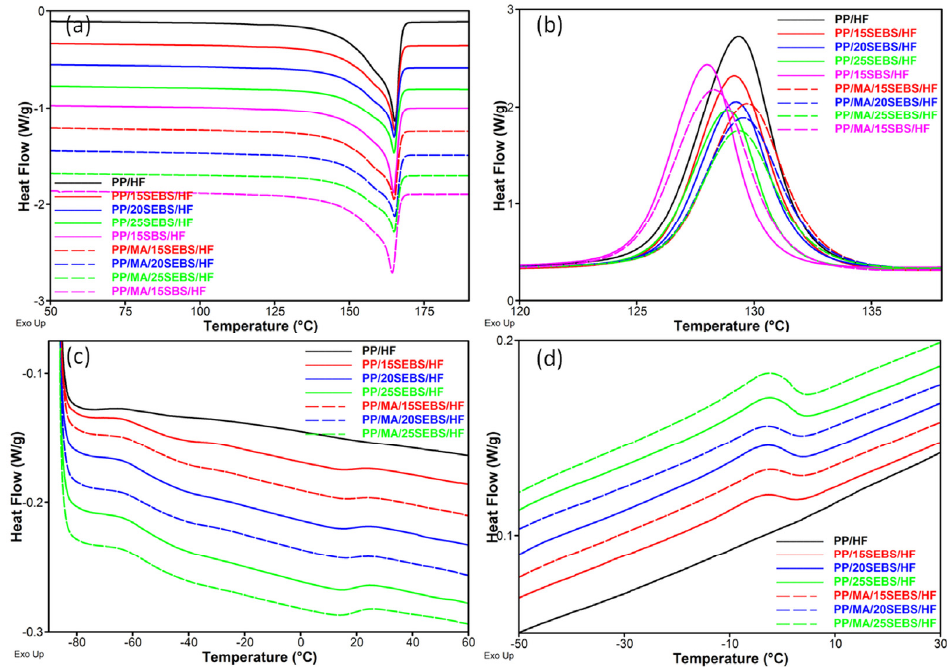
Figure 8. DSC curves of the composites: second melting cycle ( a ), cooling cycle ( b ), second melting cycle (SEBS temperature domain) ( c ), and cooling cycle (SEBS temperature domain) ( d ). Lower T c values were noticed for the composites containing SBS (Figure 8b), and slightly lower degrees of crystallinity compared to that of PP/HF were noticed for the PP/20SEBS/HF, PP/25SEBS/HF, and PP/15SBS/HF composites. However, all of the